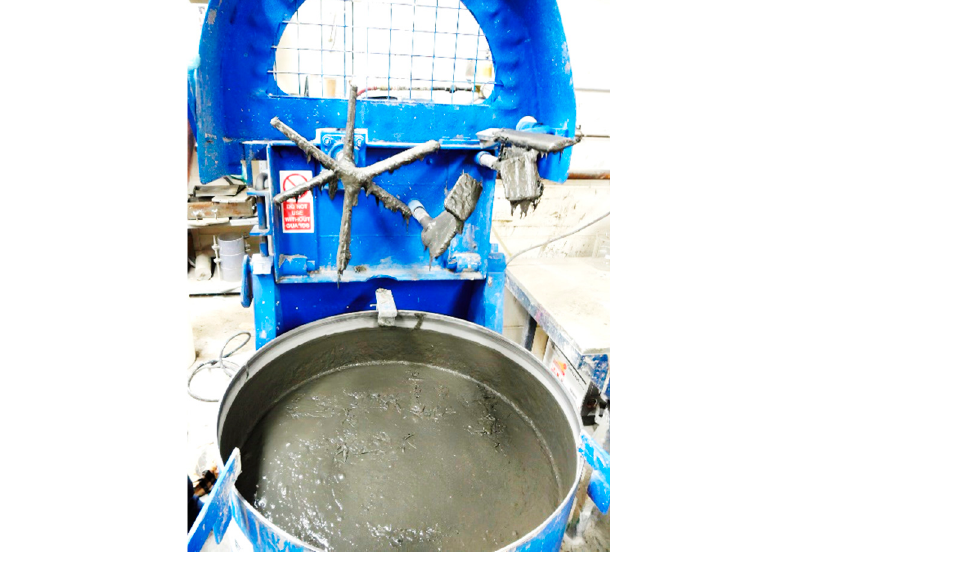
Figure 2. Shear mixer for mixing of UHPC.